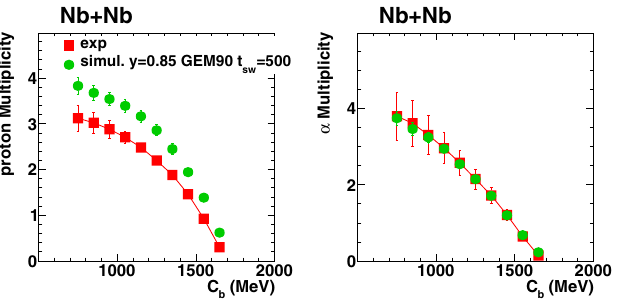
Figure 1. Experimental and simulated (best result: switching time 500 fm / c, GEMINI Fortran90 as afterburner, screening parameter y = 0 . 85) multiplicity for protons (left) and α particles (right) as a function of the centrality (estimated starting from the velocities of QP and QT, as explained in the text) in binary